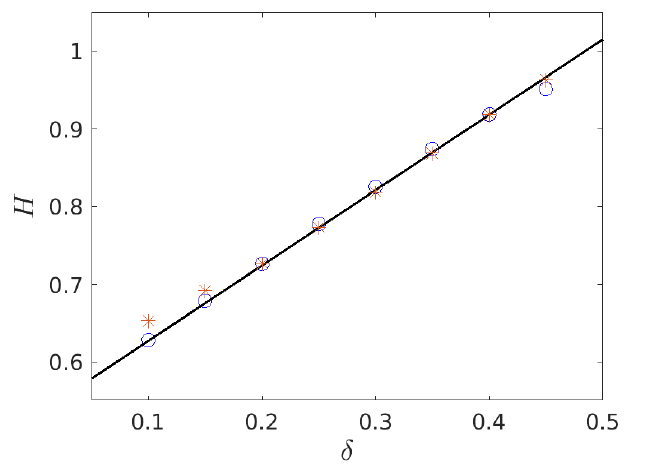
Figure 7. The plot of the Hurst exponent versus the parameter δ . The data marked by a circle and star are obtained from the MSD of stochastic processes z x ( t ) and the characteristic area, respectively. The straight guide line has been obtained by a linear regression on the data of the characteristic area and represents that H ≈ 0.94 δ +